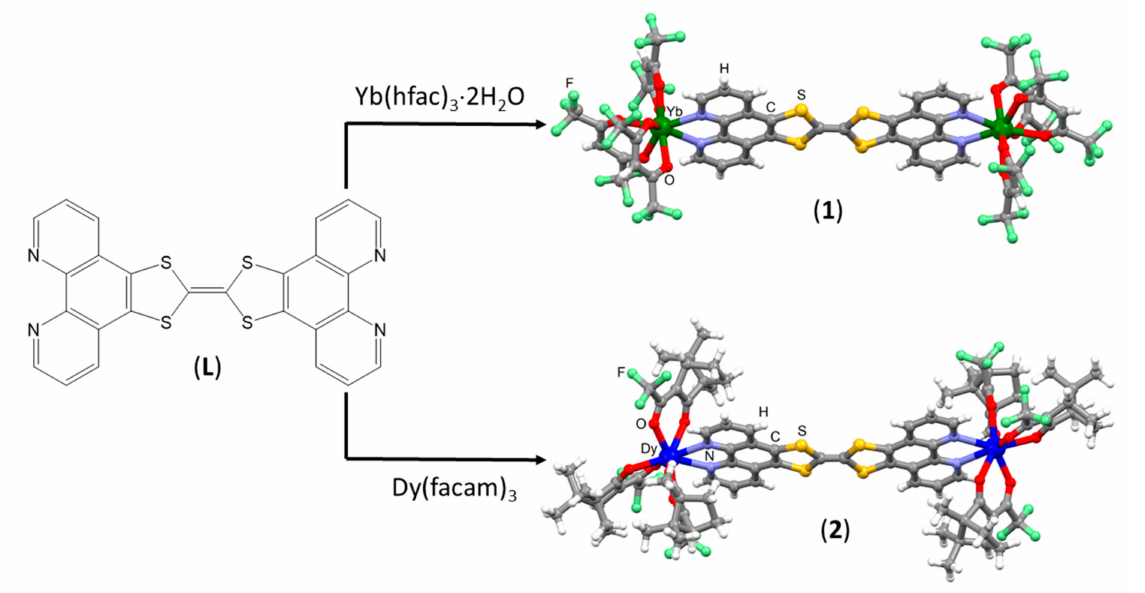
Figure 1. Coordination reactions between L and Yb(hfac) 3 (H 2 O) 2 and Dy(facam) 3 as well as molecular structures of [Yb 2 (hfac) 6 (L)] · 2(C 7 H 16 ) (( 1 ) · 2(C 7 H 16 )) and [Dy 2 ((+)facam) 6 (L)] · 2(C 6 H 14 ) (( 2 ) · 2(C 6 H 14